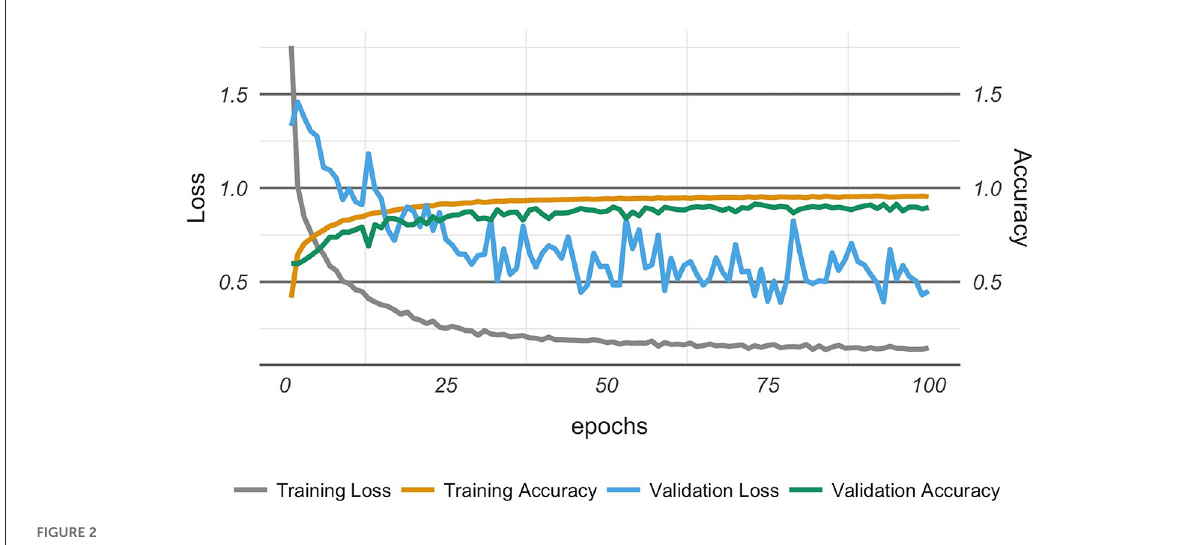
FIGURE2 Model optimization showing the model achieving optimal performance after about 50 epochs.